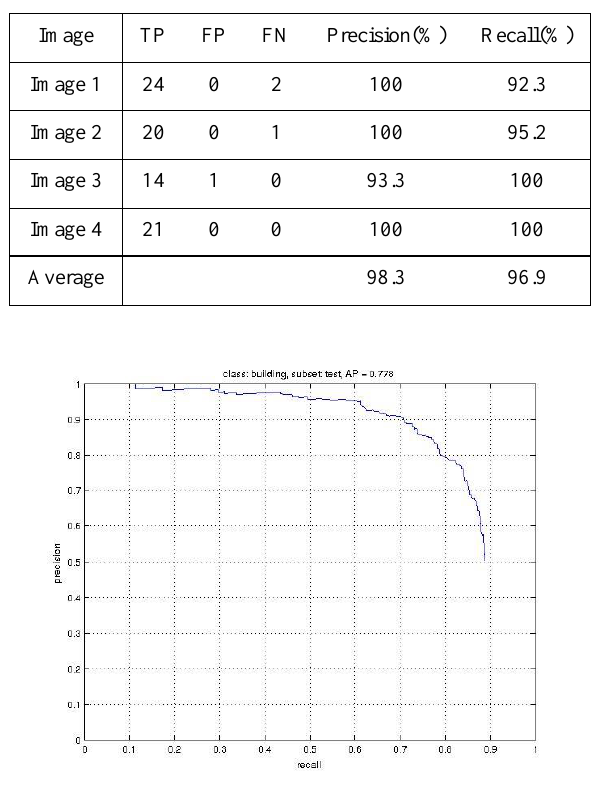
Figure 2. A number of building detection results with the building detection network in proposed model Table 2. Evaluation results of the four images